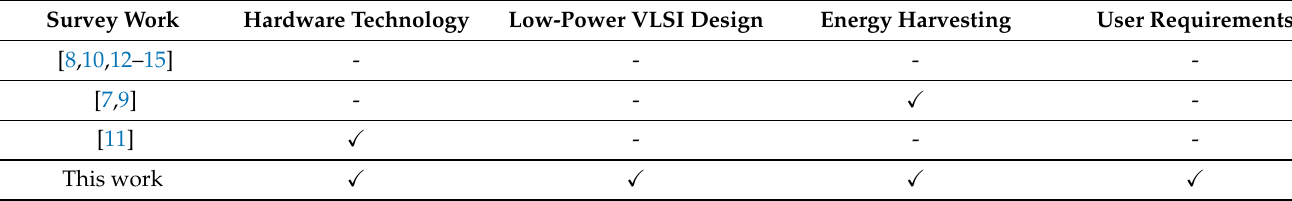
Table 3. Comparison between state-of-the-art survey